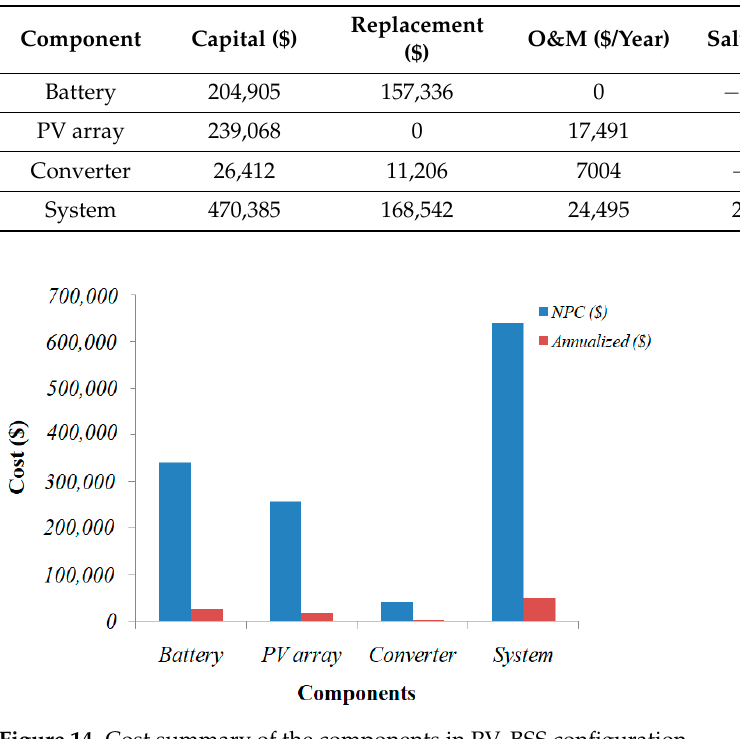
Figure 16. Electricity production in each month from PV–BSS configuration. The energy stored in BSS is utilized at peak hours or when SPV arrays cannot gener- ate electricity. Depending upon the energy output, batteries become charged between 80% and 100% from the 9th to the 19th h. This can be observed from the red-colored region in Figure 17. The monthly SOC of BSS is provided in Figure 18. Figure 17. Yearly profile of the SOC of batteries for PV–BSS configuration.